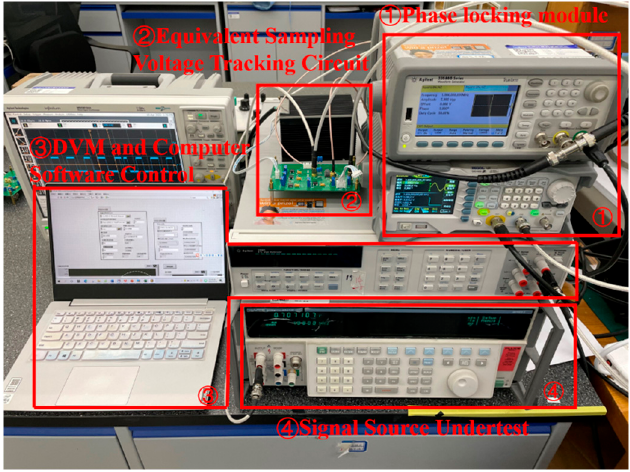
Figure 4. Physical drawing of measurement system.